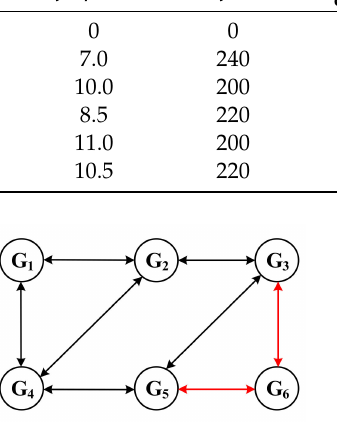
Table 1. Parameter values of each distributed generator.